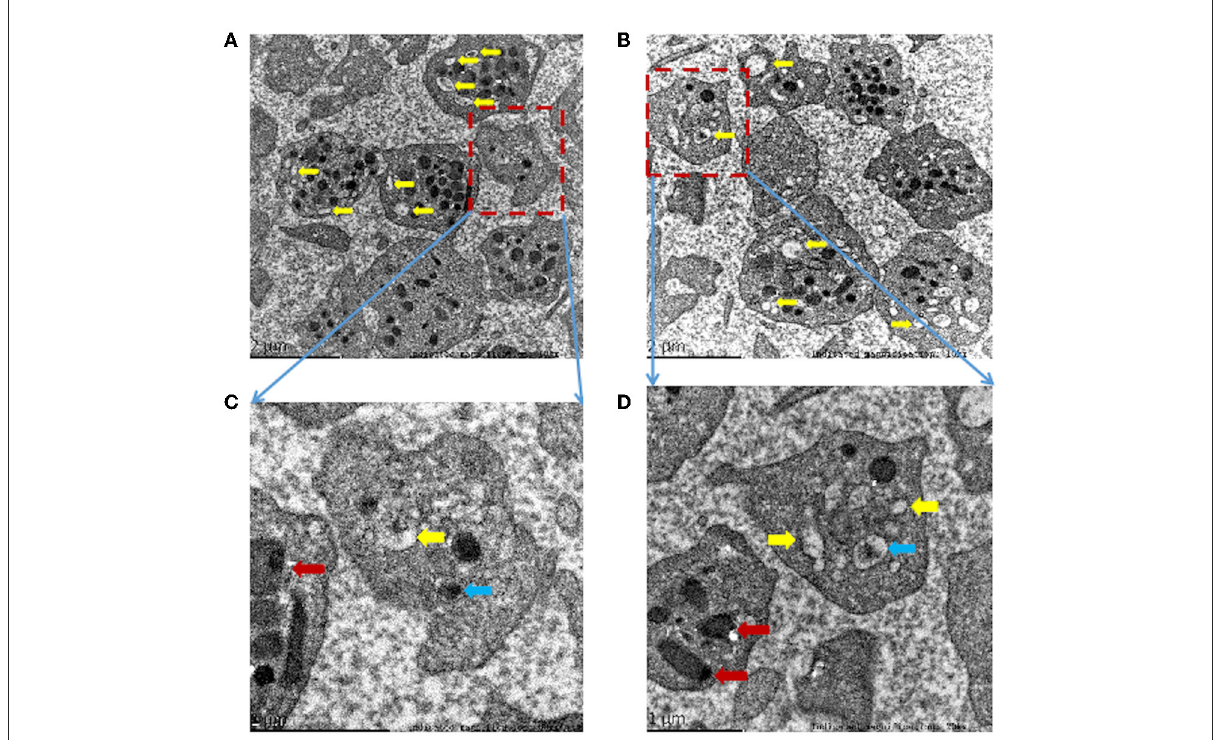
FIGURE4 (A–D) Morphological analysis of platelets by platelet transmission electron microscopy (PTEM) shows multiple empty sacks (yellow arrows) in the proband’s platelets without dense granules. Occasionally, abnormally dense granules with irregular shapes, decreased the content density and increased clear space (blue arrow). The platelet lysosomes (red arrow) increase in volume. Indicated magnification: (A) 10kx, (B) 10kx, (C) 30kx, (D)